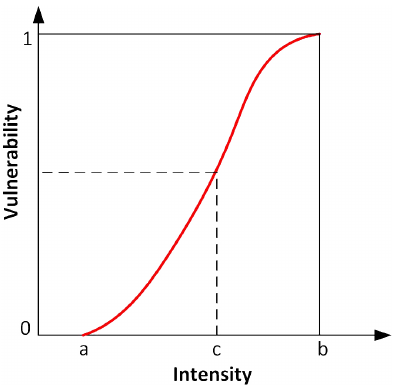
Figure 2. An example illustration of a generic vulnerability curve using a CDF. The input parameters a , b and c are obtained from the user to generate the vulnerability curve with or without class (type) information for a certain category of elements at risk.